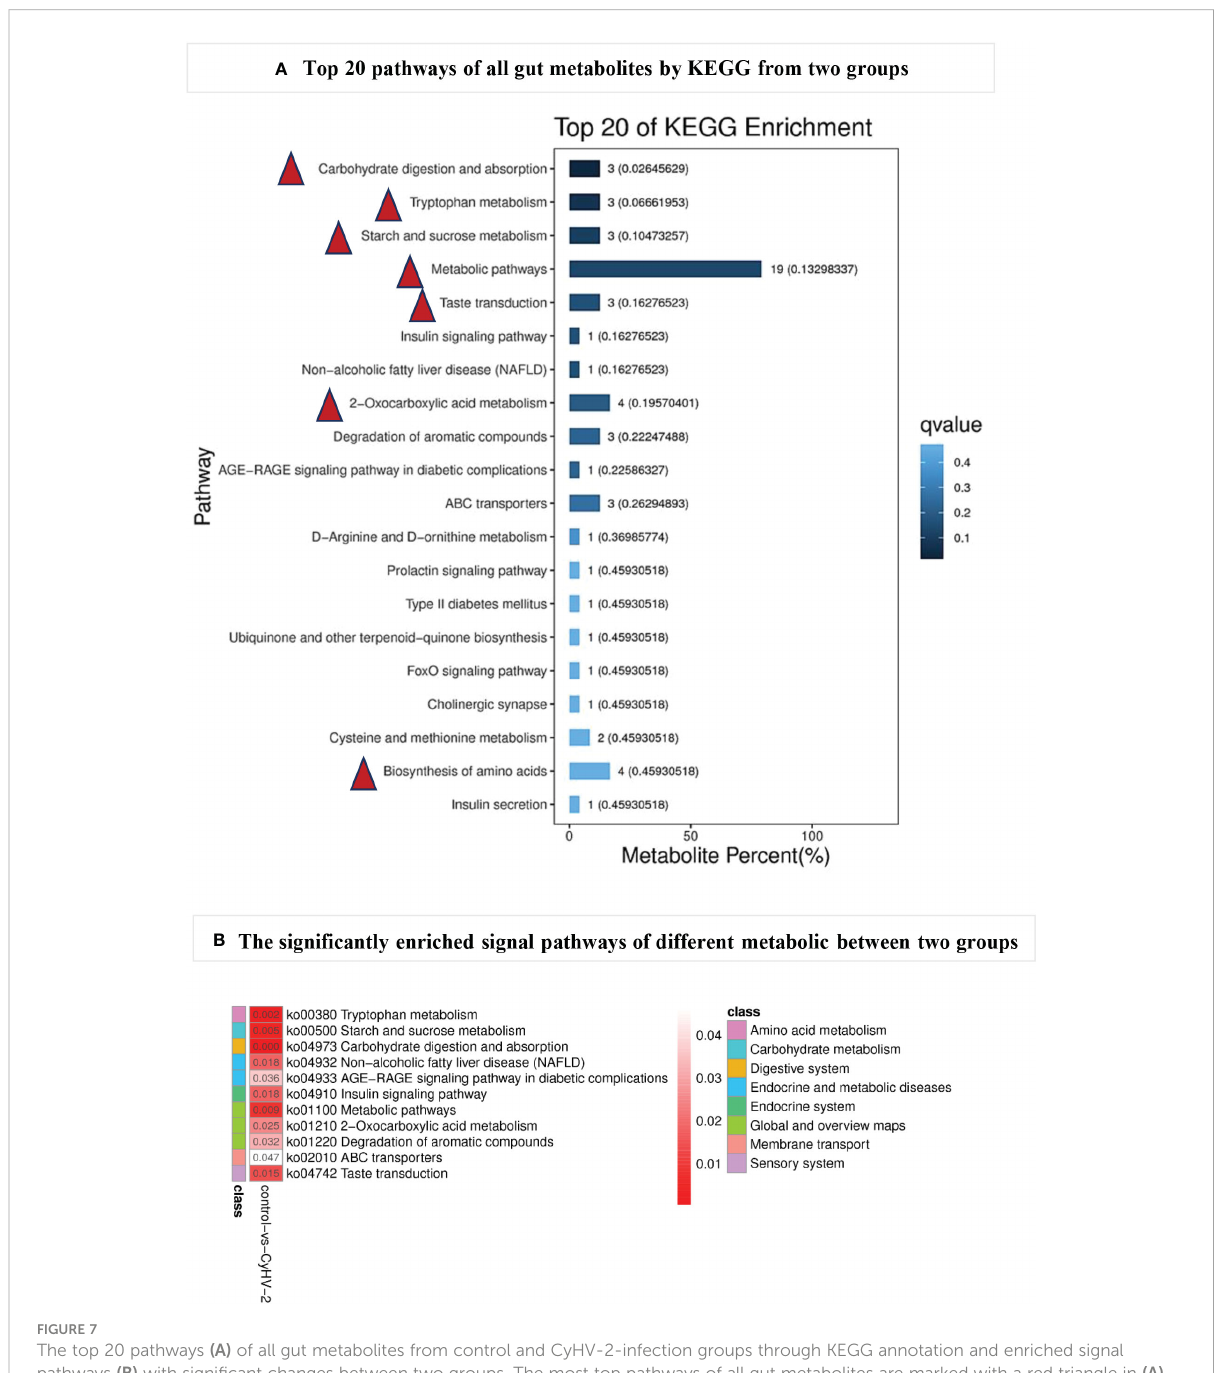
FIGURE 7 The top 20 pathways (A) of all gut metabolites from control and CyHV-2-infection groups through KEGG annotation and enriched signal pathways (B) with signi fi cant changes between two groups. The most top pathways of all gut metabolites are marked with a red triangle in (A) and the most signi fi cantly different pathways with a red arrow in (B) The colors and numbers in panel B represent the signi fi cance of metabolic pathways. The higher signi fi cance, the smaller the number and the darker the